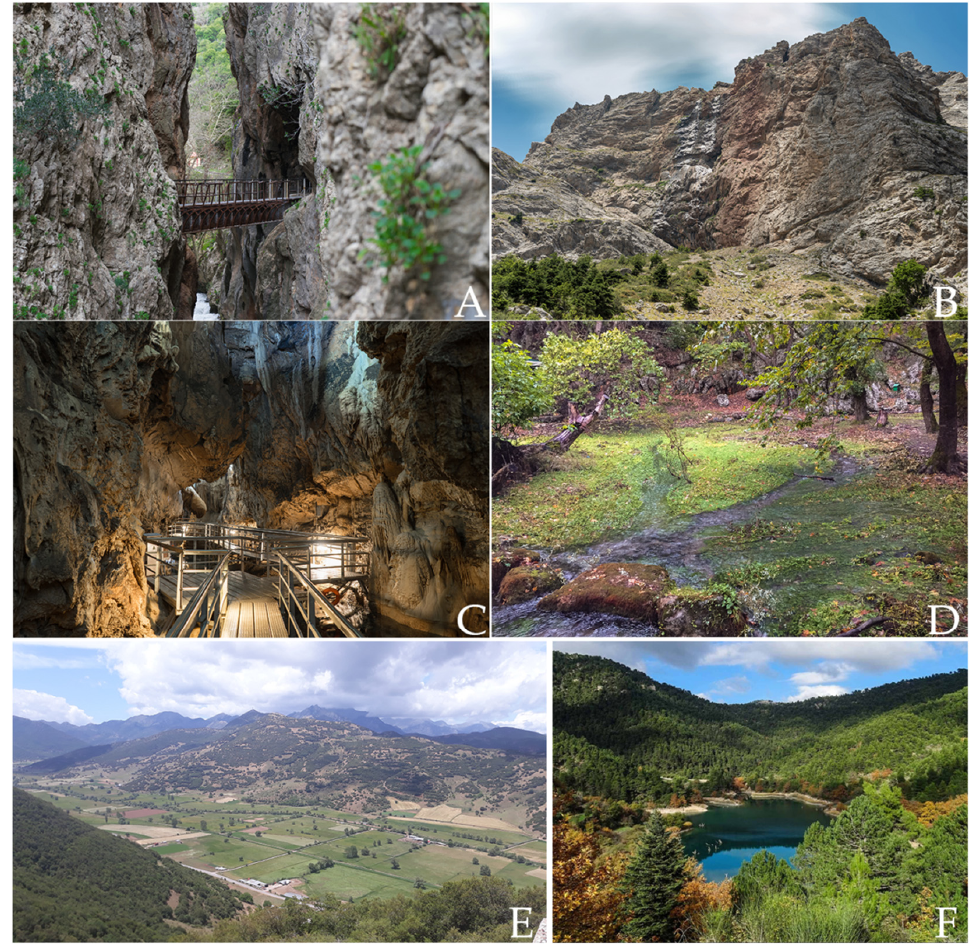
Figure 2. Representative views of the geosites described in the results. ( A ) Portes-Triklia, geosite 2, ( B ) The Water of Styx, geosite 20, ( C ) Cave of the Lakes, geosite 11, ( D ) Aroanios Springs, geosite 14, ( E ) Tectonic graben of Kalavryta, geosite 07, ( F ) Tsivlos Lake, geosite 19.